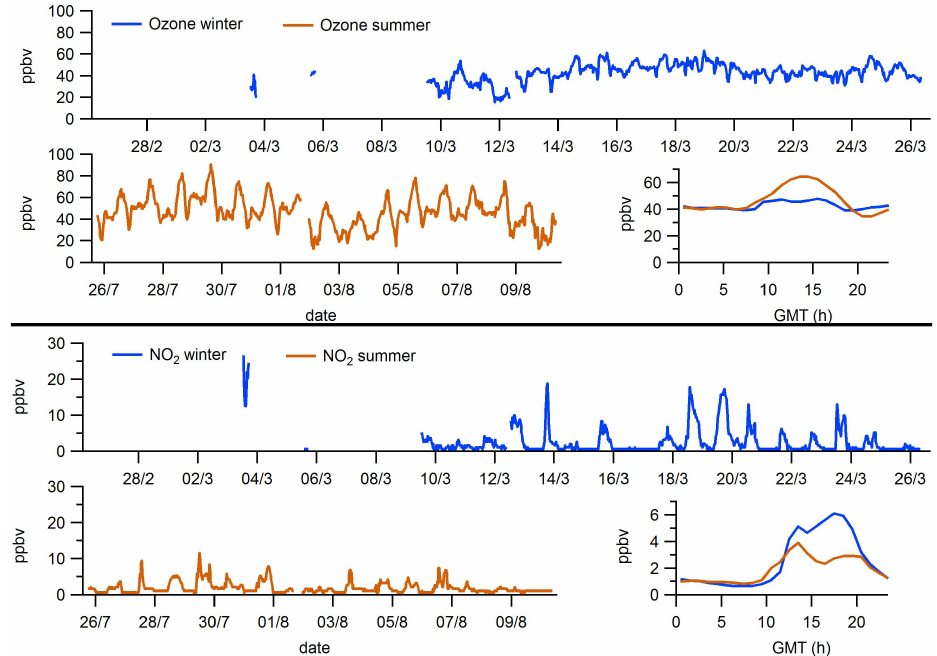
Fig. 4. Ozone and nitrogen dioxide mixing ratios during the winter period (upper graph of each panel), during the summer period (lower left graph) and their mean daily cycles (hourly averages) for both periods (lower right graph). Date labels indicate 00:00